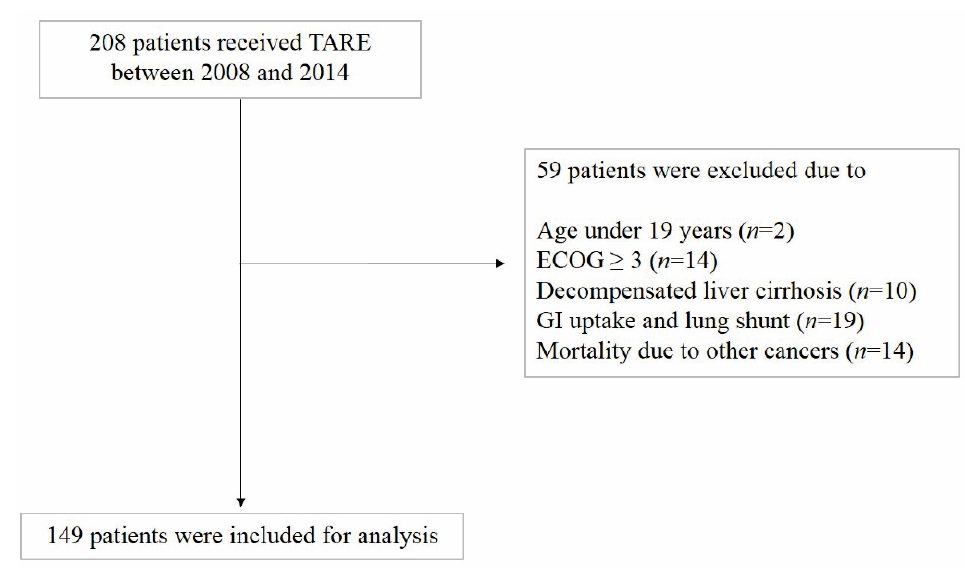
Figure 1. Flow chart of the patient selection process.